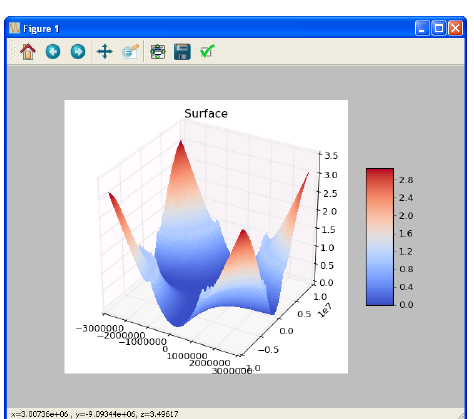
Fig. 19. The surface of distortions generated by developed